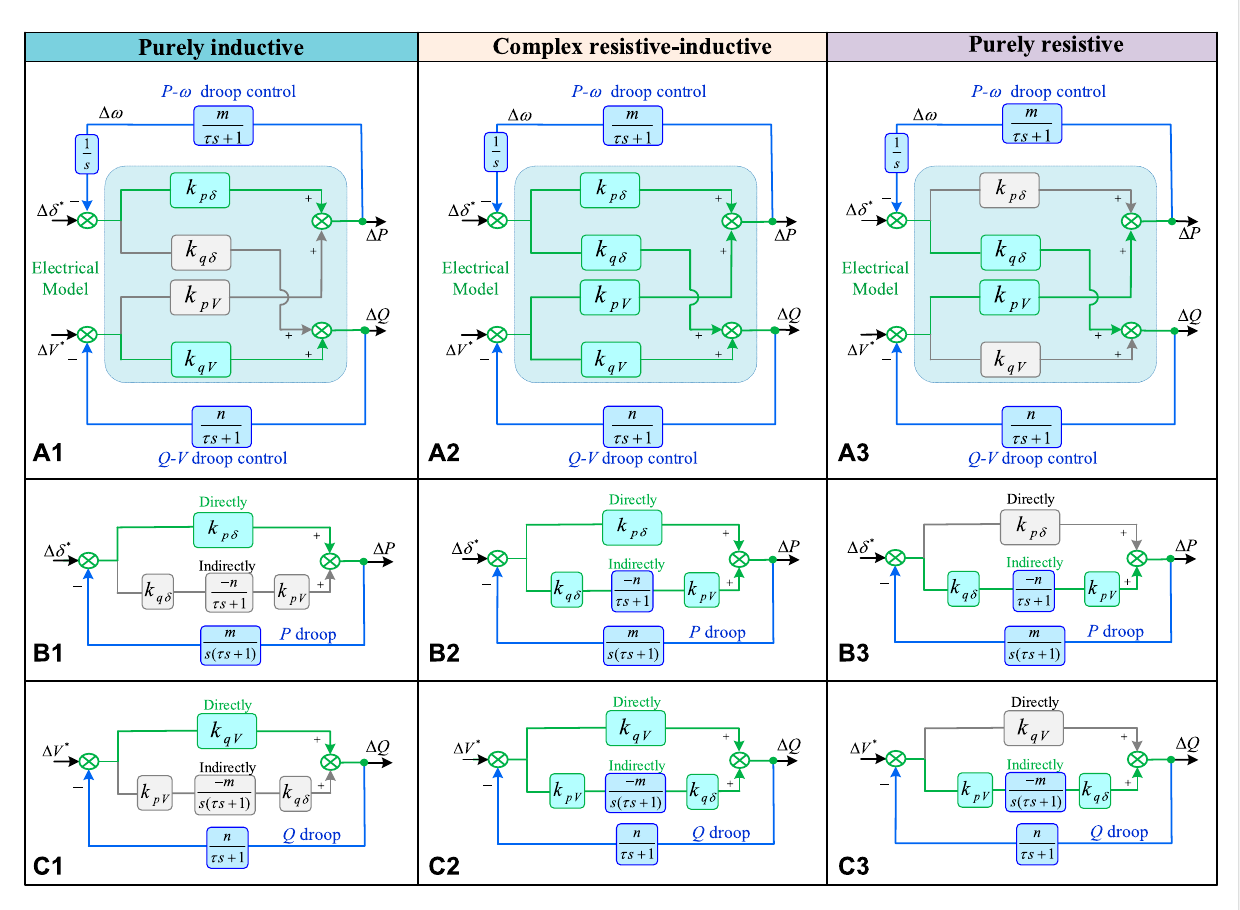
FIGURE 9 Control block diagram under different line impedances. (A) Overall small-signal block diagram; (B) decomposed active control; (C) decomposed reactive